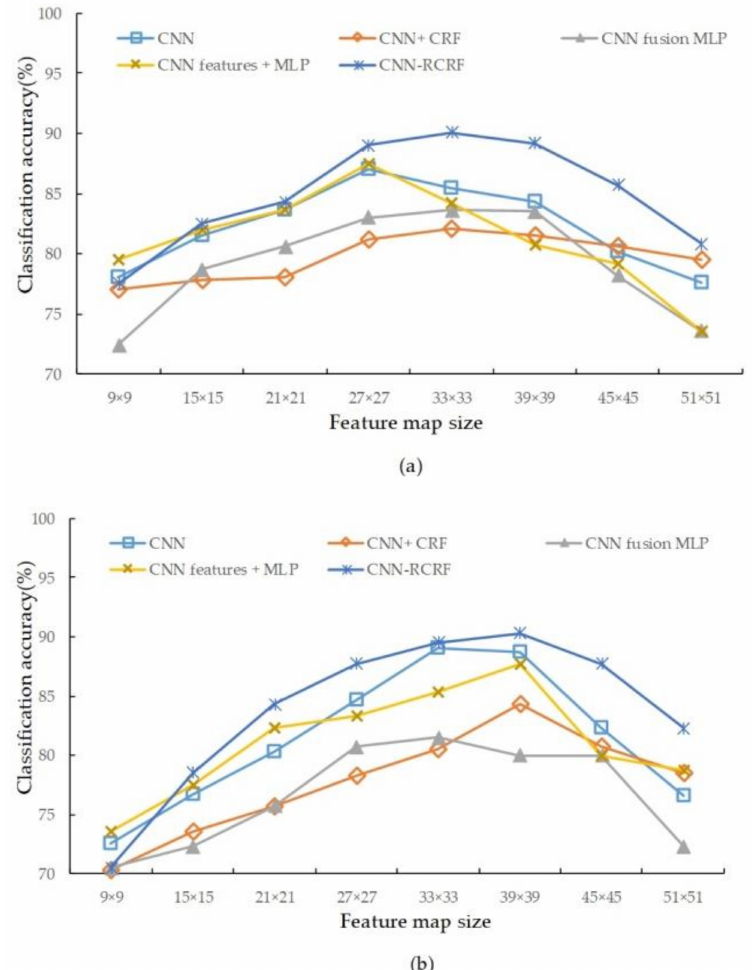
Figure 8. Comparison of the five deep-model methods in in eight feature map size. ( a ) Study image 1; ( b ) Study image